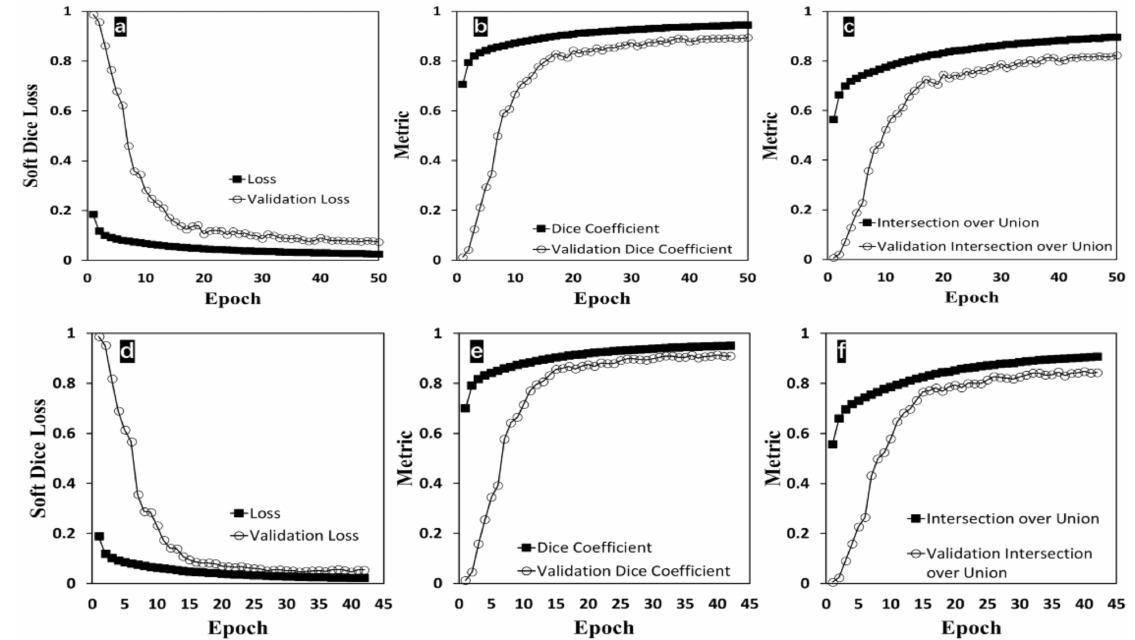
Figure 8. U-Net model training with 10% of training data as the validation. ( a ) Soft dice loss function with respect to epoch; ( b ) dice coefficient as the metric with respect to epoch; ( c ) IoU as the metric with respect to epoch (a, b, and c are from the model training with the binary results from this proposed cell segmentation method). ( d ) soft dice loss function with respect to epoch; ( e ) dice coefficient as the metric with respect to epoch; ( f ) IoU as the metric with respect to epoch (d, e, and f are from the model training with the ground truth data generated from manually